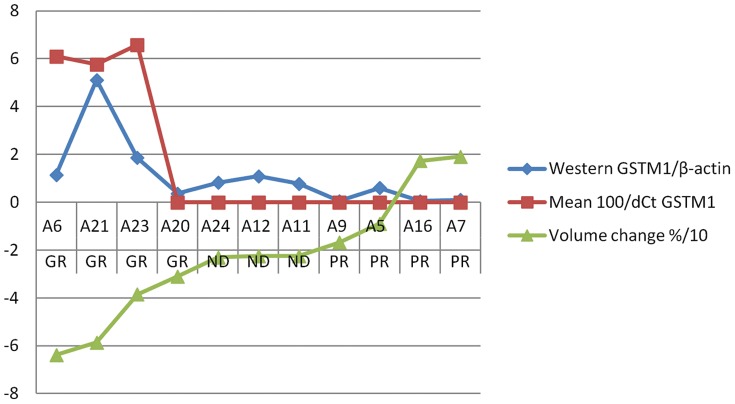
Correlation of leiomyoma volume change (percentage ×0.1) and the expression levels of GSTM1 as studied by real time PCR and Western blot GR = good responders, PR = poor responders, ND = not determined (in between groups) category.